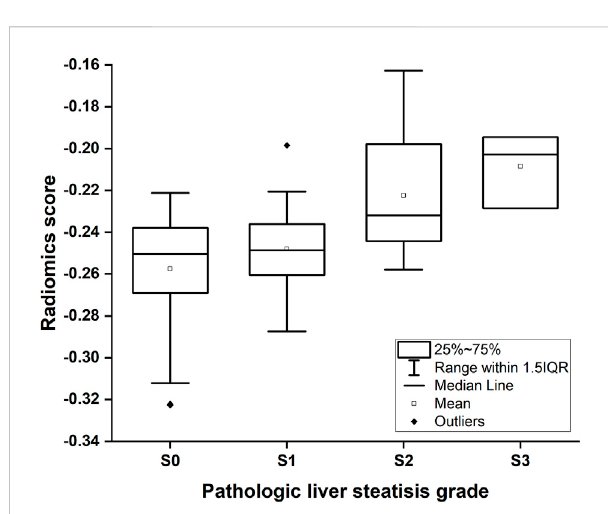
FIGURE 4 Box-and-whiskerplotoftheradiomicsscoreforeachpathologic liver steatosis stage calculated from the radiomics model in the trainingcohort.ThemedianvaluesoftheradiomicsscoreforstageS0, S1, S2 and S3 were − 0.250, − 0.248, − 0.232, and − 0.203,